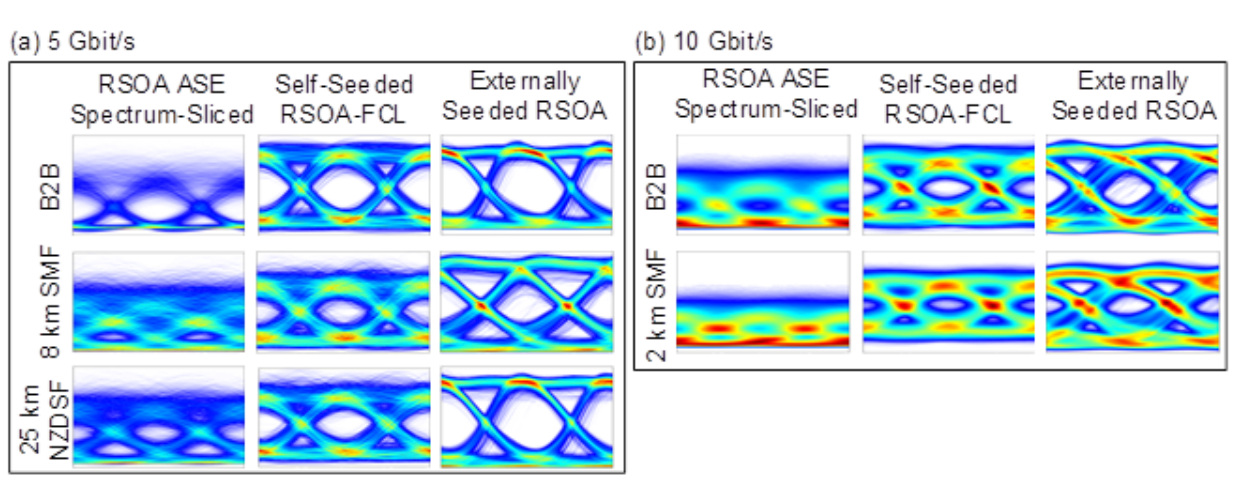
Figure 15. Eye diagrams: ( a ) Measured eye diagram for 5 Gbit/s transmission and ( b ) 10 Gbit/s transmission with the three transmitter schemes. The measurements were performed at a received power of −12 dBm. The transmission distances are indicated in the